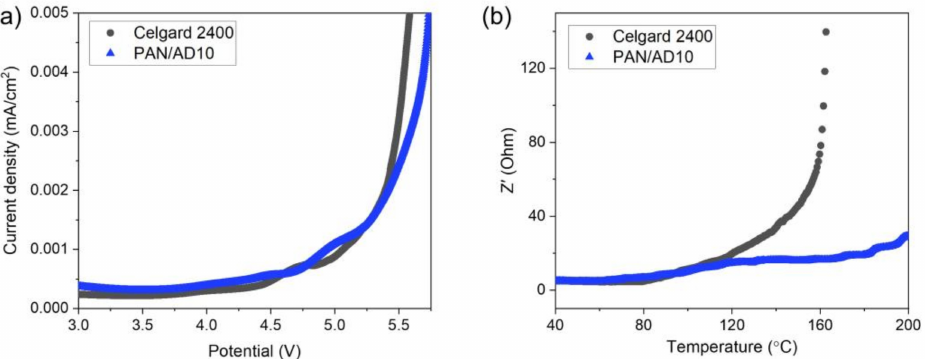
Figure 6. ( a ) Electrochemical stability and ( b ) heat resistance curves of Celgard 2400 and PAN/AD10 with LE. The electrochemical stability (Li/membranes with LE/SS cells) was measured at room tem- perature and a scan rate of 0.1 mV/s in the range of 3.0 − 5.7 V. For the heat resistance (SS/membrane with LE/SS with Kapton tape), the cells were heated to 200 ◦ C at a rate of 2 ◦ C/min, and their electrochemical impedances were simultaneously measured at 1